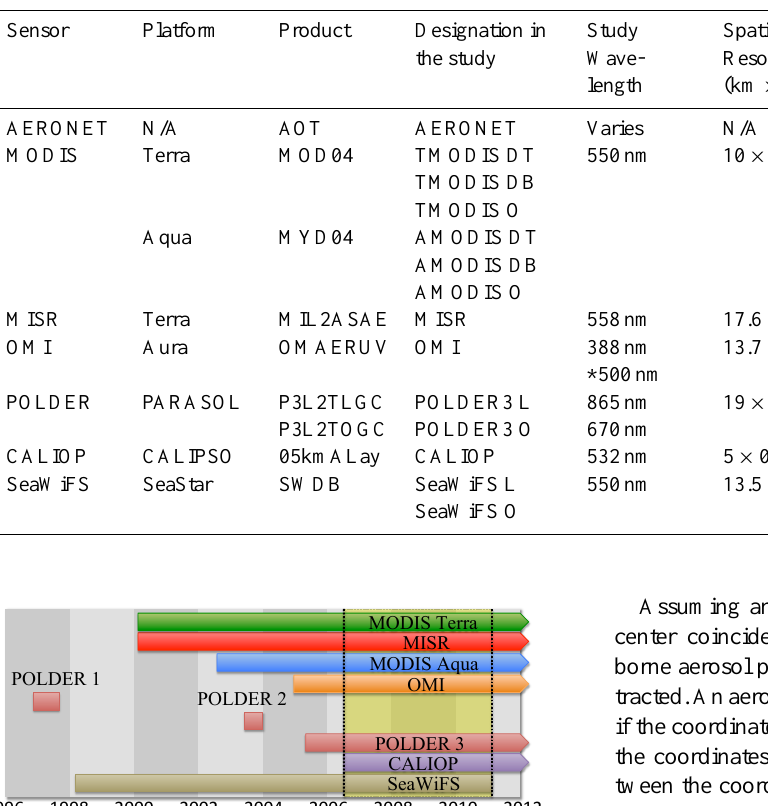
Table 1. Ground-based and spaceborne atmospheric aerosol products analyzed in the study. In the product designation titles, “O” at the end of the title of a product signifies ocean retrievals, “L” – land retrievals, “DT” – land retrievals using the MODIS Dark Target algorithm, and “DB” – land retrievals using the MODIS Deep Blue algorithm. The AERONET AOD retrievals were interpolated to the studied wavelengths of the spaceborne sensors. The indicated local equatorial crossing times (LT) are based on the original orbital designs, and can change during the lifetimes of the satellites. SeaWiFS mission has ended in December 2010. * While 388nm was the main observational wavelength used in the study for OMI, 500nm was used where the collocated AERONET data were not available in the UV range.